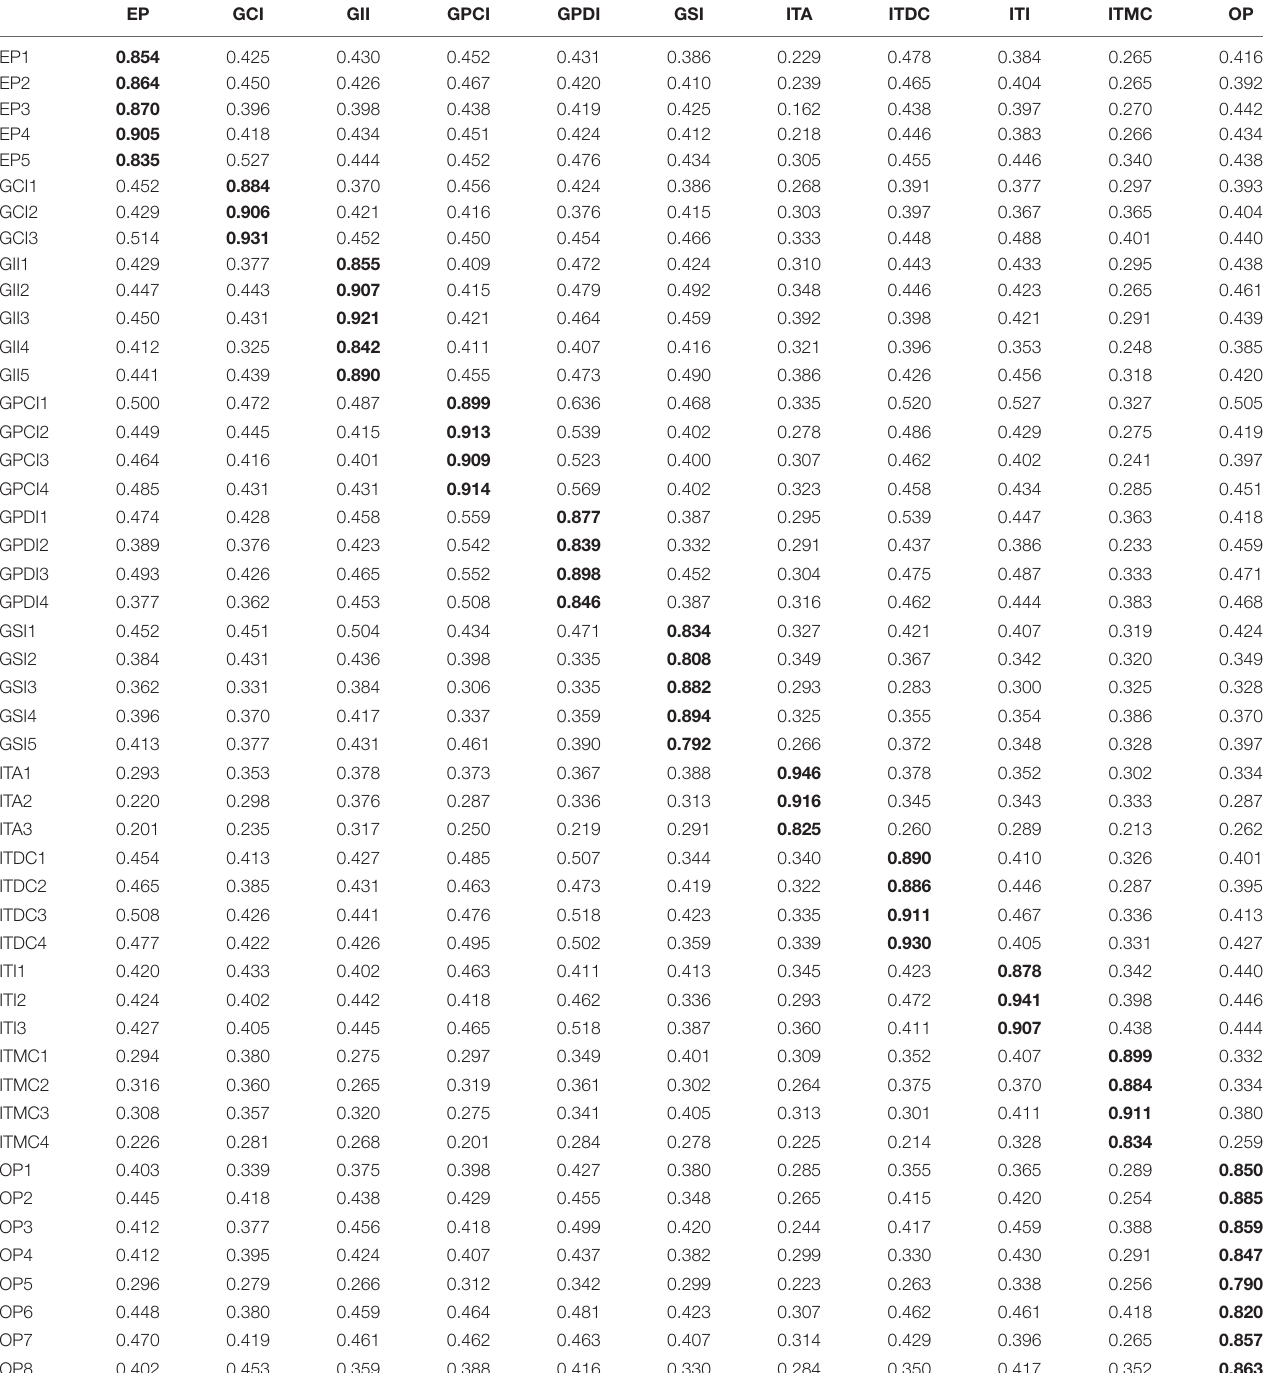
TABLE 4 | Constructs